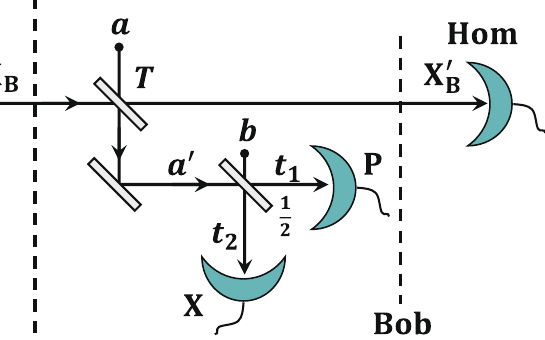
Figure 4. Schematic of the energy test at Bob’s side. Bob uses a beam splitter with transmissivity T to split the incoming signal into two parts. The transmission mode ′ X mode a ′ is exploited to perform the energy test. a and b are two vacuum modes induced by beam splitters. Modes t 1 and t 2 are the output modes of the balanced beam splitter used for checking whether | | q below a certain